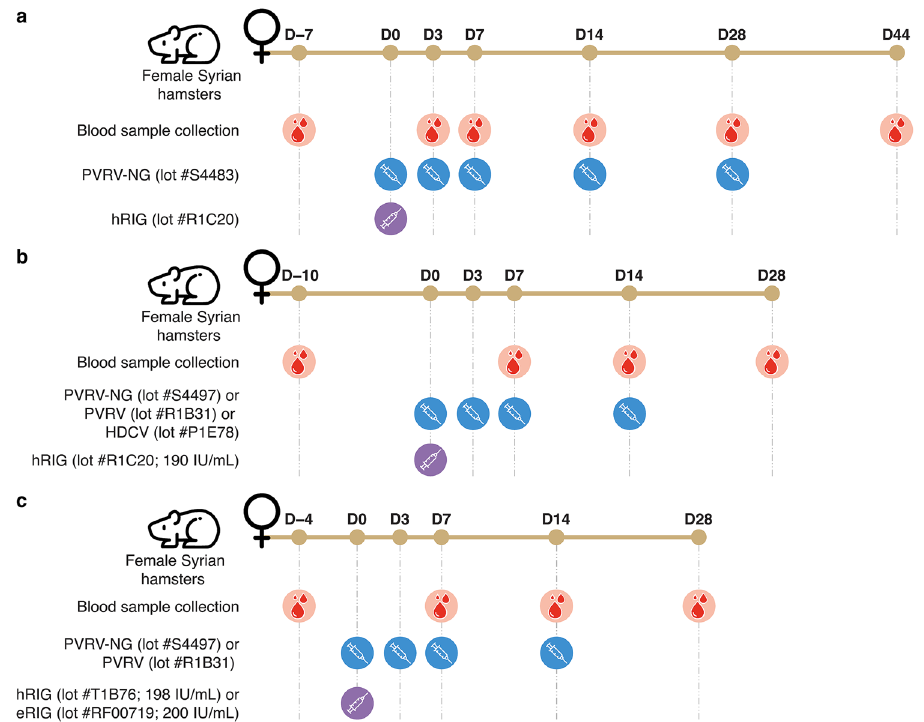
Figure 1. Schematic illustration of vaccination schedule. Female Syrian golden hamsters were injected with standard-of-care rabies vaccines/vaccine candidate (left limb), rabies immunoglobulin (RIG) (right limb), or vaccine + RIG. Blood samples were collected for analysis as illustrated. The preliminary experiment and experiment 1 were performed at Voxcan, France and experiment 2 was conducted at Sanofi, Marcy L’Etoile, France. ( a ) In the preliminary experiment, hamsters were randomized to receive PVRV-NG (n = 12), human RIG (hRIG; n = 12), or concomitant injections of PVRV-NG and hRIG (n = 12). Animals were injected IM with a volume of 100 µL (1:5 HD) of PVRV-NG on Days 0, 3, 7, 14, and 28 (as the 5-dose Essen regimen) and/or a volume of 50 µL of hRIG (20 IU/kg) on Day 0. ( b ) In experiment 1, hamsters were randomized to receive PVRV-NG (n = 12), PVRV (n = 12), HDCV (n = 12), hRIG (n = 6), or concomitant injections of any of the vaccines and hRIG (n = 12 in each group). Animals were injected IM with a volume (1:10 HD) of 100 µL of HDCV, or 50 µL of PVRV or PVRV-NG on Days 0, 3, 7, and 14 (as the 4-dose Essen regimen) and/or a volume of 50 µL of hRIG (20 IU/kg) on Day 0. ( c ) In experiment 2, hamsters were randomized to receive PVRV-NG (n = 12), PVRV (n = 12), hRIG (n = 3), equine RIG (eRIG; n = 3) or concomitant injections of any of the vaccines and hRIG/eRIG (n = 12 in each group). Animals were injected IM with a volume (1:10 HD) of 50 µL of PVRV